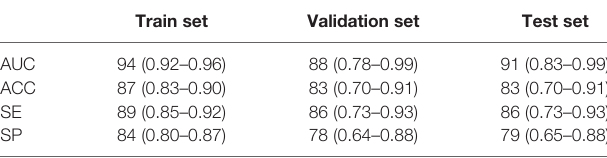
TABLE 2 | Predictive performance of the CNN model.